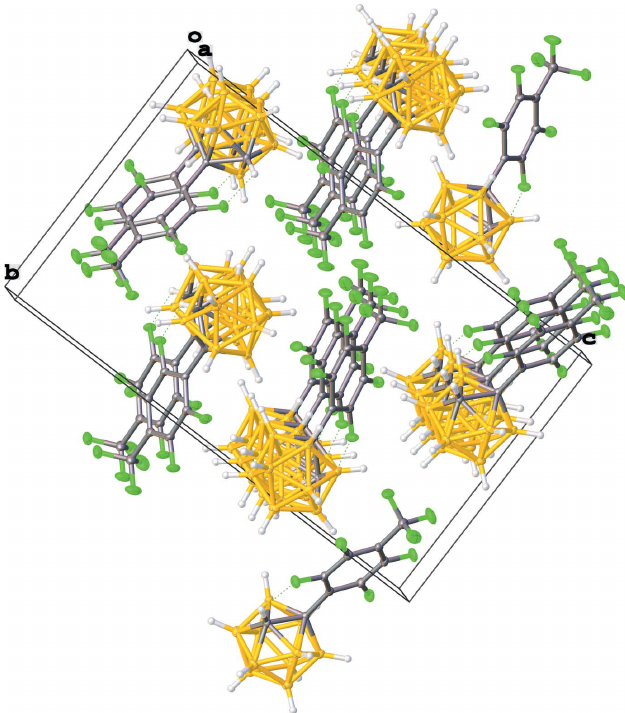
Figure 2 Unit cell of [1-(4 0 -F 3 CC 6 F 4 )- closo -1,2-C 2 B 10 H 11 ] in a view along